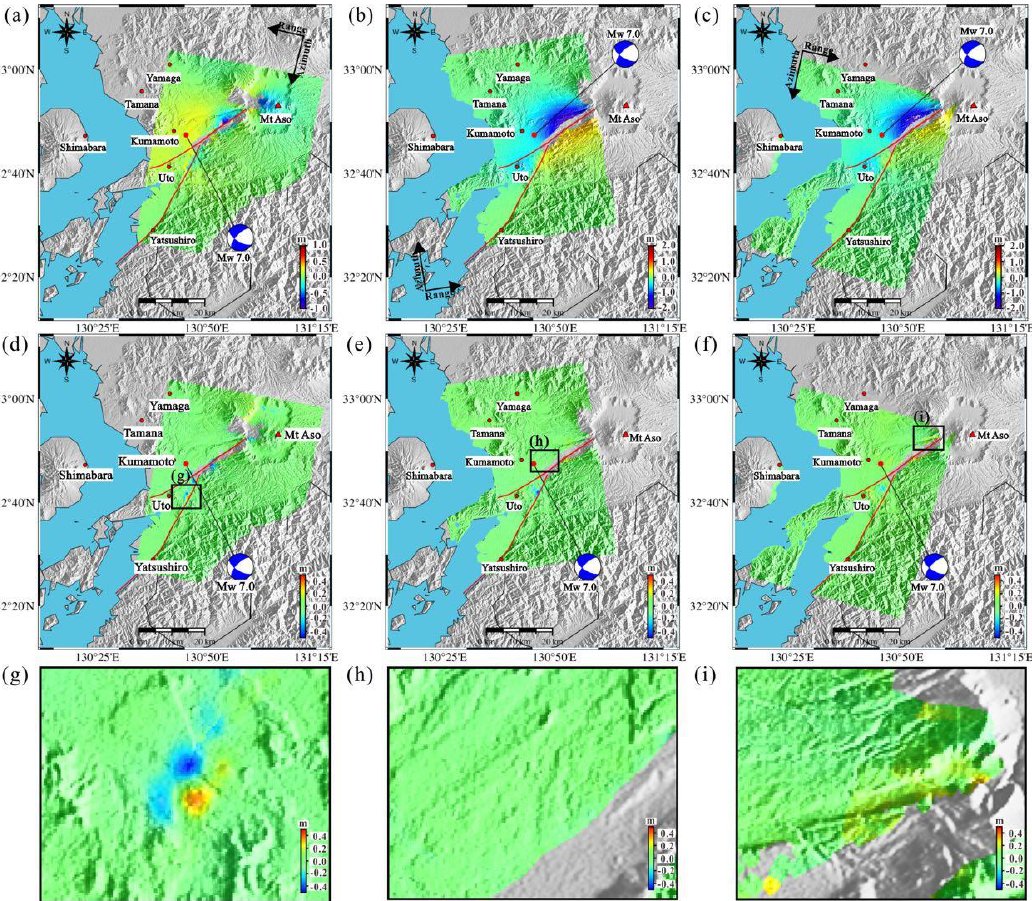
Figure 5. Coseismic surface deformation in InSAR LOS direction predicted from the AR–DR slip model. ( a – c ) are, respectively, the simulated DR, AR, and DL InSAR deformation, and ( d – f ) are the corresponding residuals between the observed and modeled ones. ( g – i ) are the magnified diagrams of the marked rectangle regions in ( d – f ).